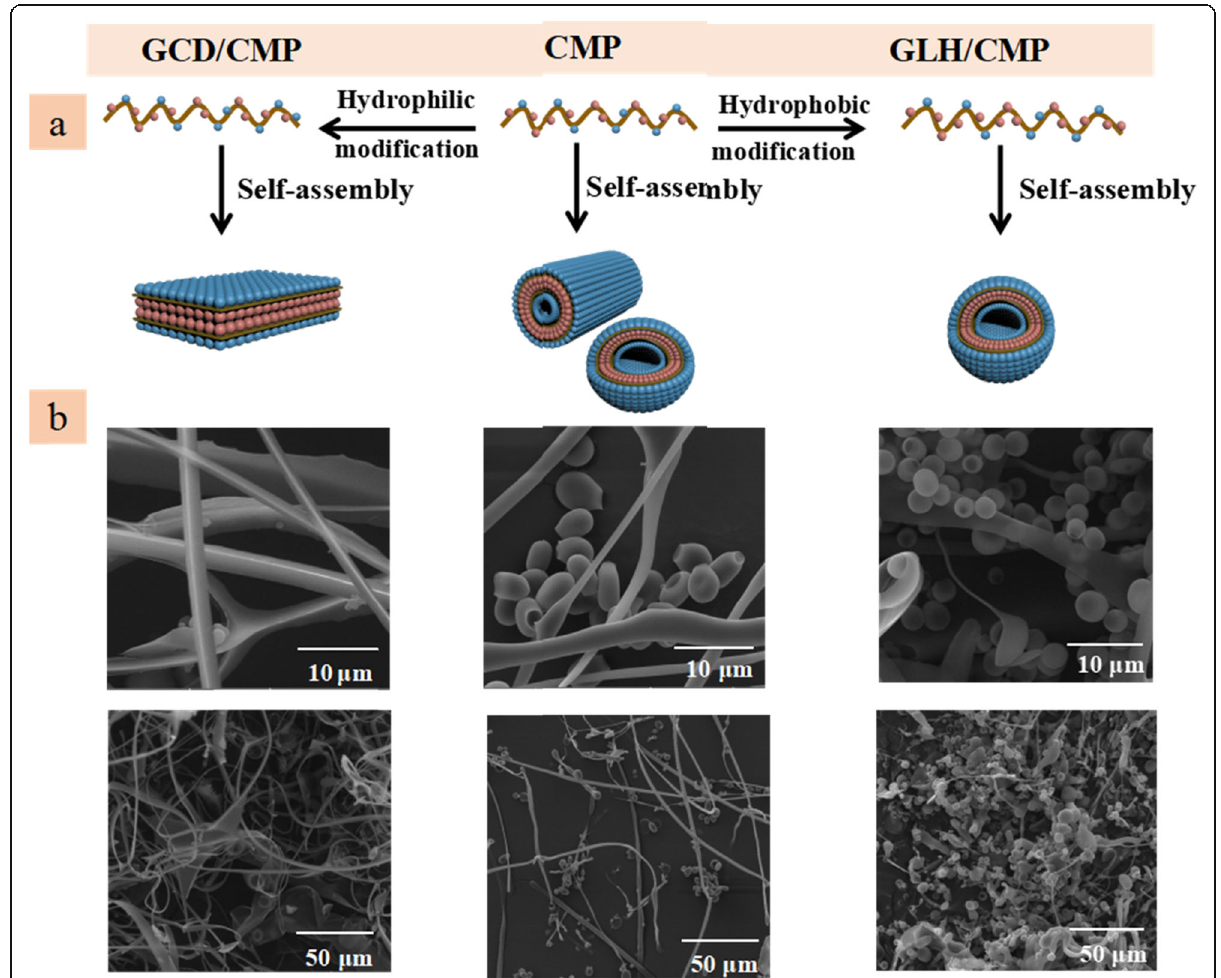
Fig. 3 Self-assembly SEM image, in which a represent schematic diagram and b represent SEM